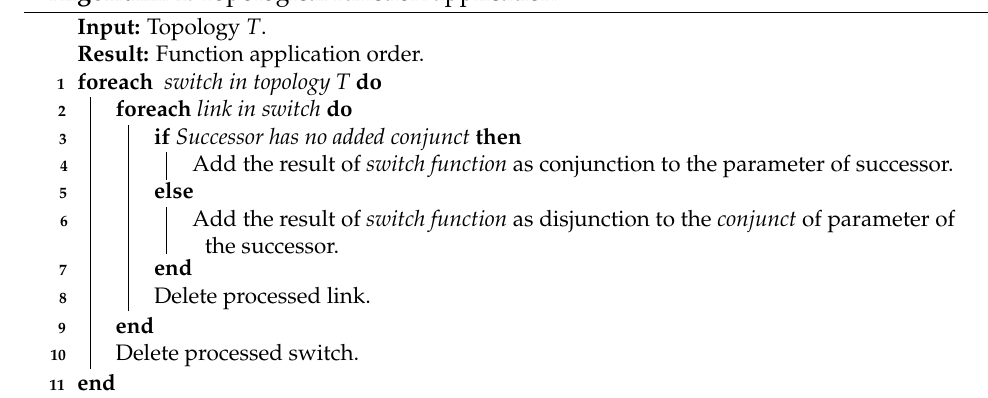
Algorithm 1: Topological function